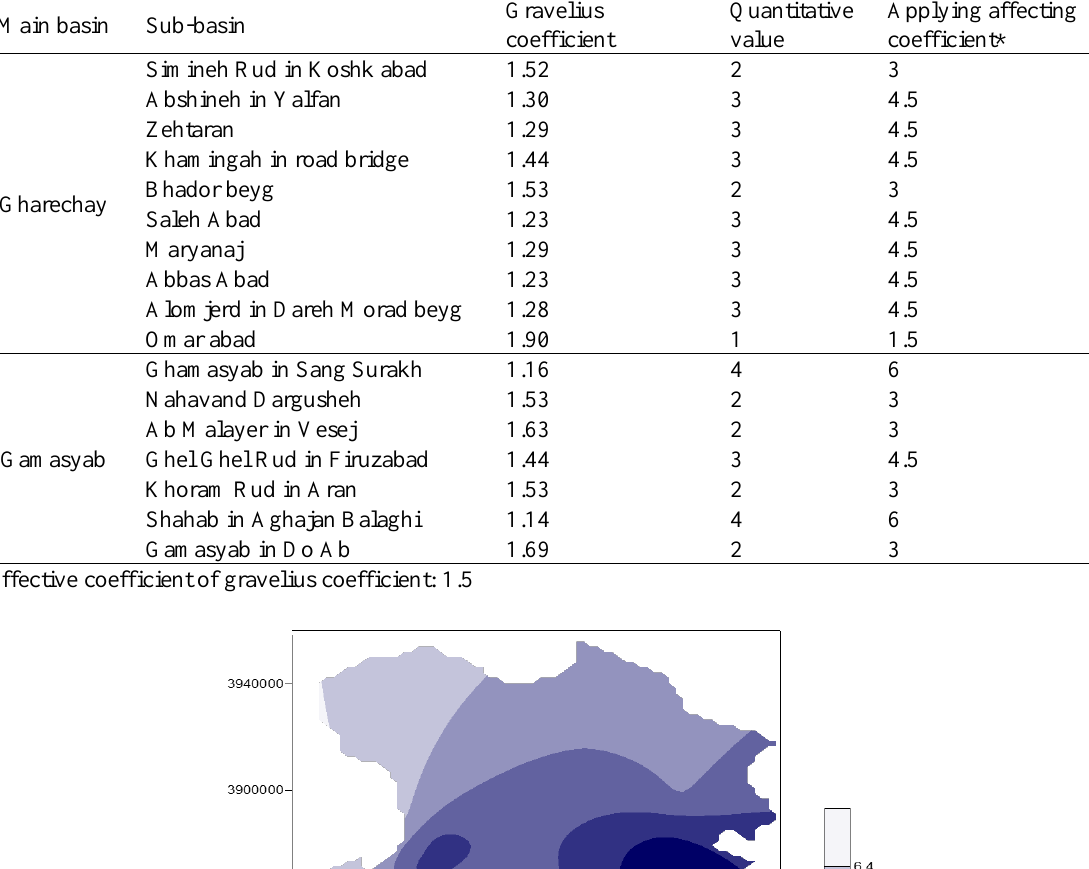
Table 4. Gravelius coefficients of Gamasyab and Gharechay sub-basins Main basin Sub-basin